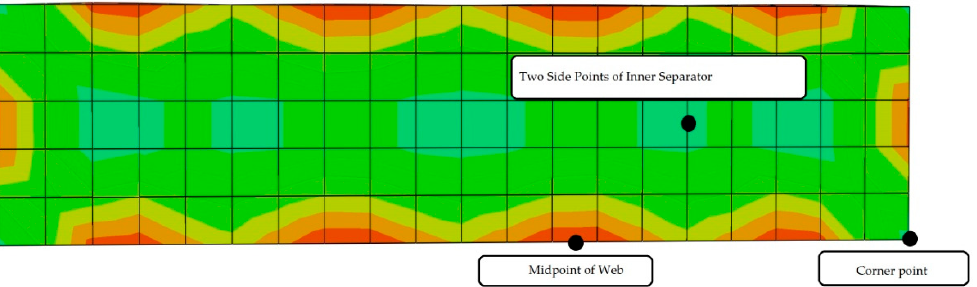
Figure 21. Distribution of Concrete Characteristic Points (H/2).